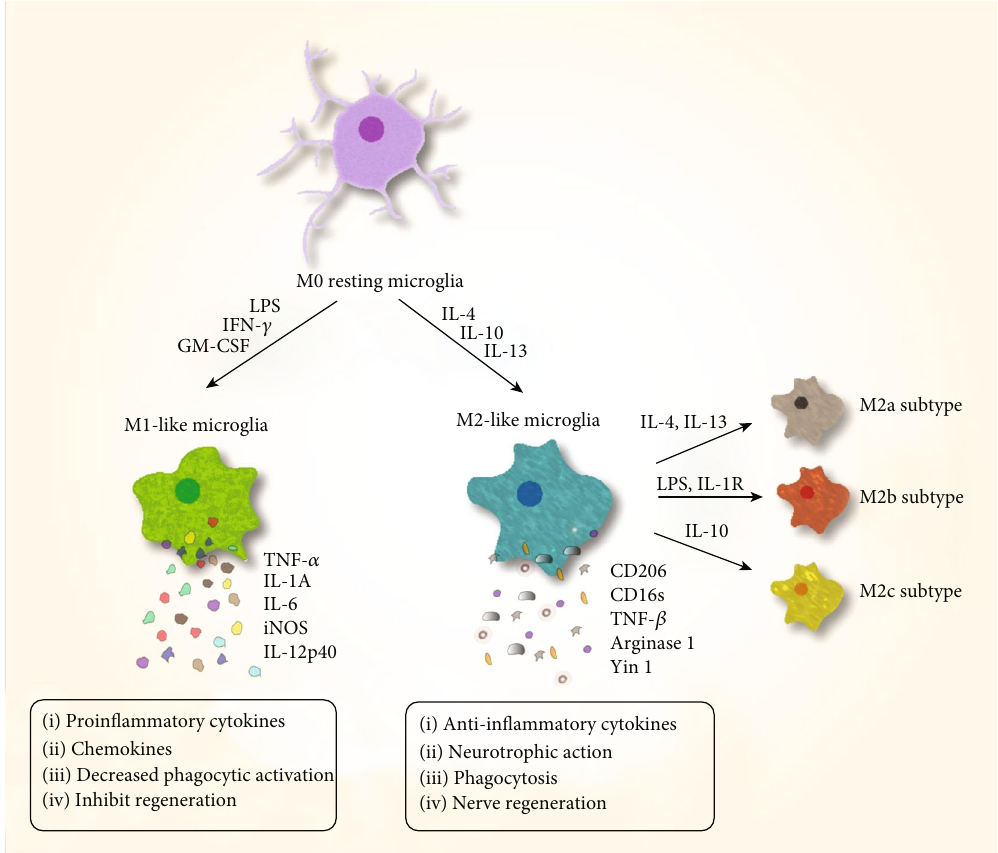
Figure 2: Active microglial phenotypes: microglia can be activated by di ff erent types of cytokines. Active microglia have two polarization phenotypes, M1 and M2 [3, 4,